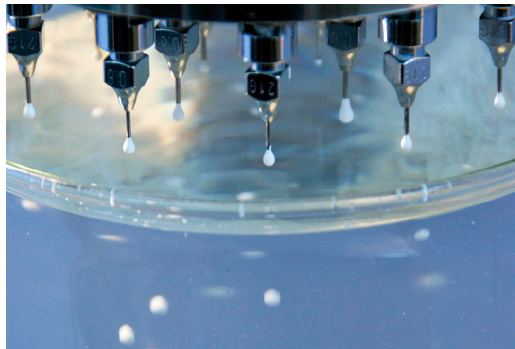
Figure 3. Drip casting process: cross-linking involves the cooperative bonding of divalent metal ions.